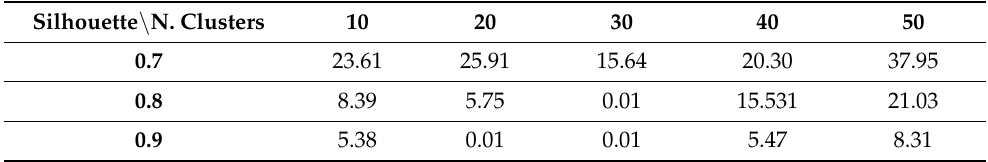
Table 51. Clustering performance in terms of silhouettes using the reduced dataset with SPQR. Silhouette \ N.